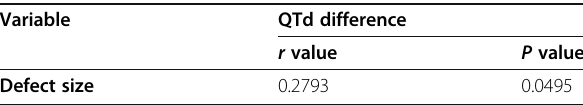
Table 3 Correlation between QTd difference and defect size in patients with abnormal perfusion scan (group no. 1) Variable QTd difference r value P value Defect size 0.2793